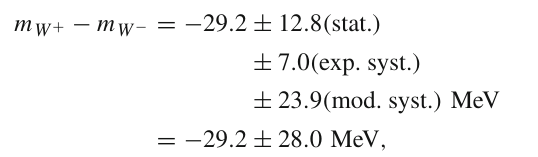
the combination. The electron channel measurement com- and m T fits in three | η (cid:7) | bins), while bines six categories ( p (cid:7) T